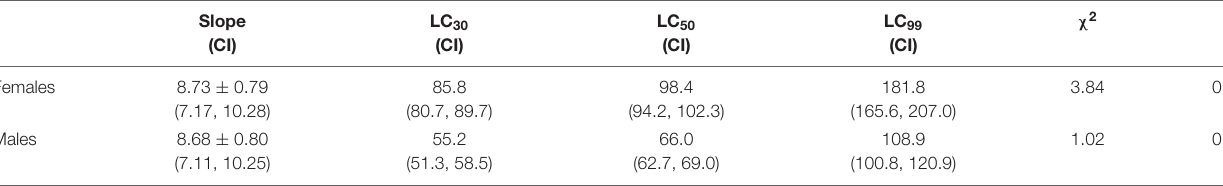
TABLE 1 | Residual contact toxicity of thymol against adult females and males of Acanthoscelides obtectus